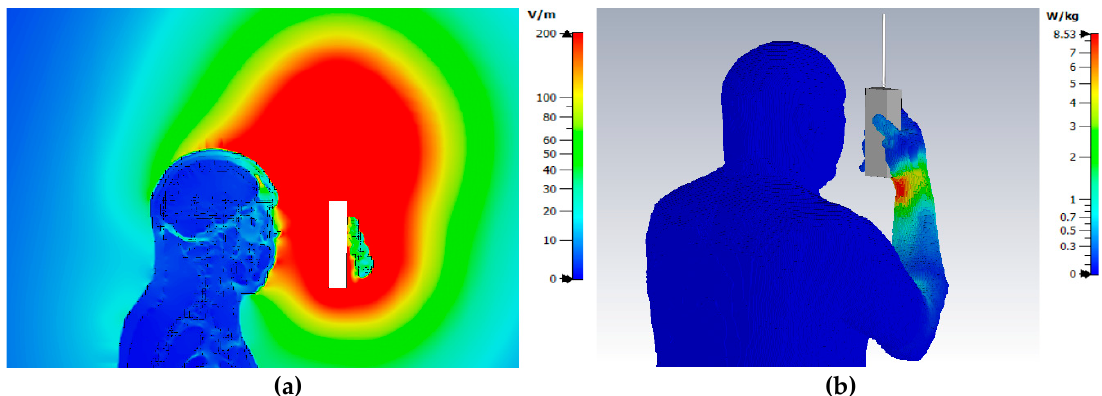
Figure 6. The electric field strength rms (root-mean-square) value distribution: ( a ) on the sagittal plane of the body model; ( b ) SAR hotspot location.